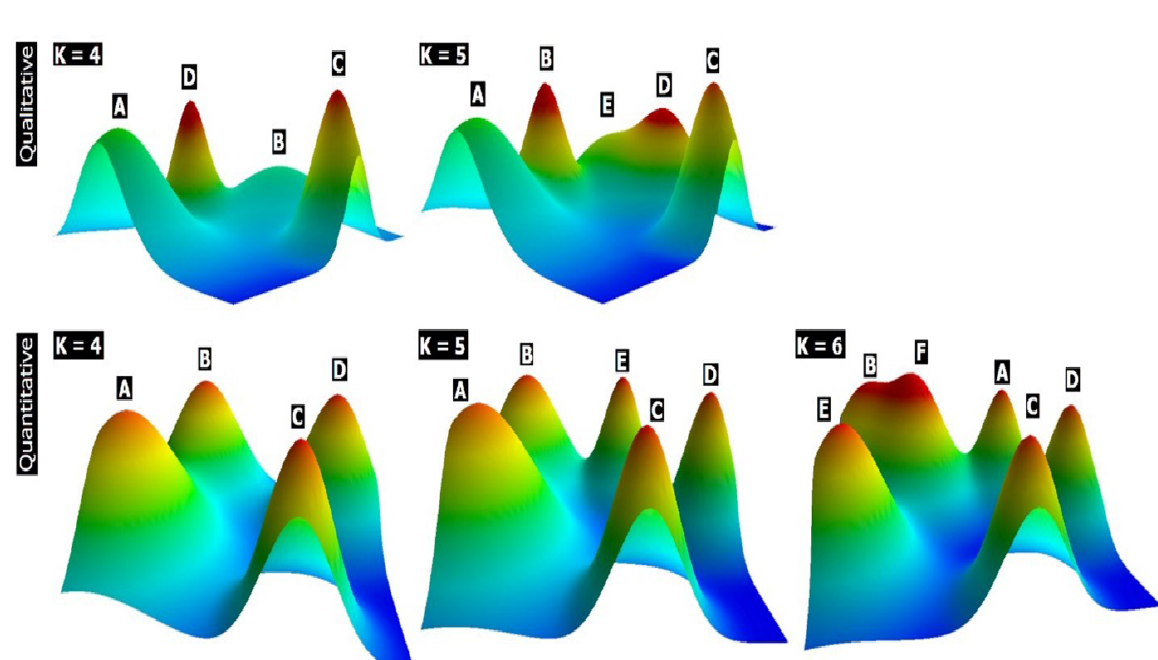
Figure 5. Mountain visualization of k-means clustering analysis combined with multidimensional scaling. Membership of each species in clusters are presented in Table 5. Taxa are grouped in 4 or 5 clusters using qualitative or quantitative datasets, respectively, and groupings concordant to clustering and PCO